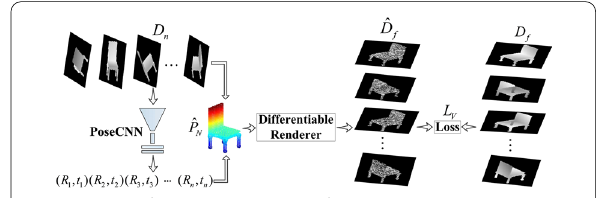
Figure 4 Novel viewpoint poses prediction